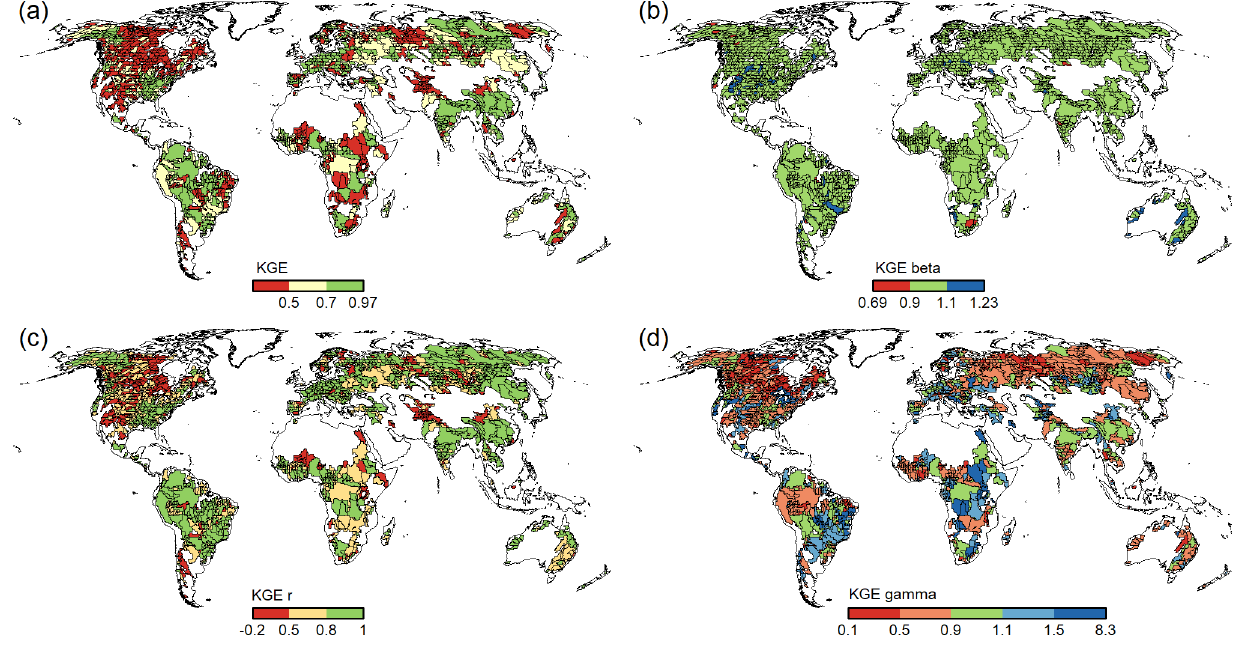
Figure 8. Classified KGE efficiency metric and its components for the 1319 river basins in WaterGAP